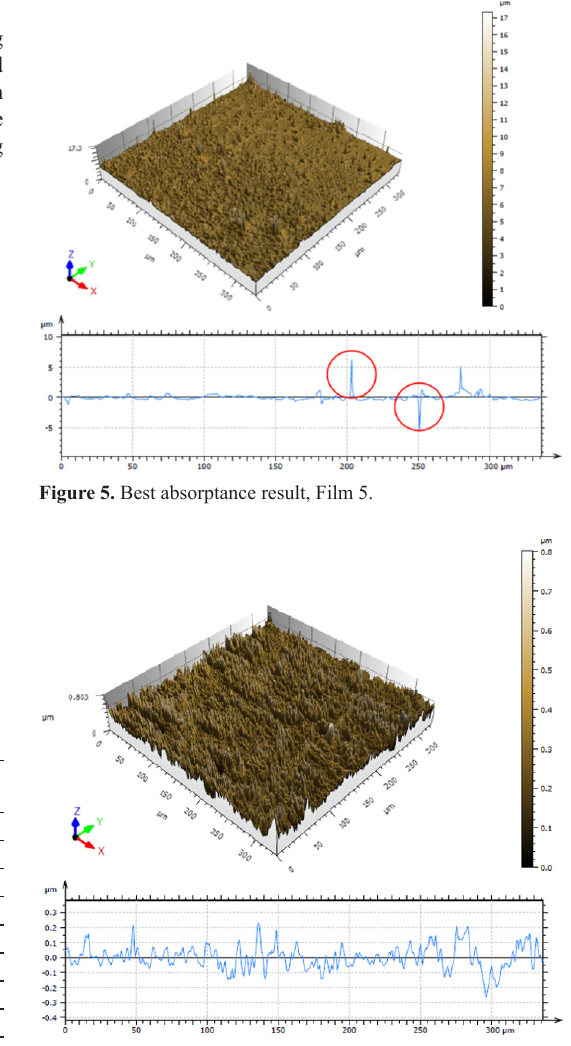
Figure 6. Worst absorptance result, Film